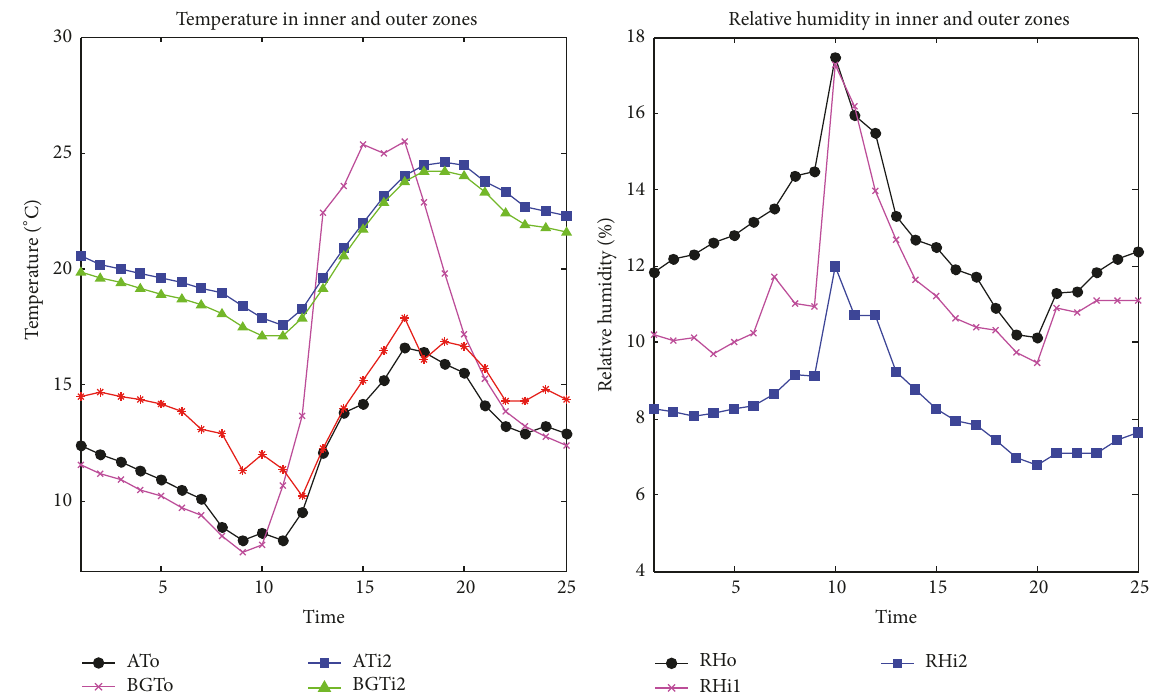
Figure 7: Comparison of the thermal environment in the inner and outer